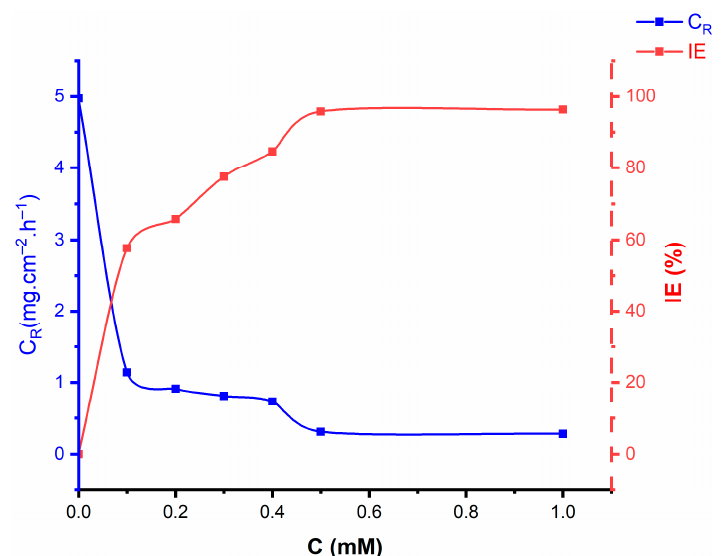
Figure 2. Effect of various concentrations of nicotinehydrazide derivative on the corrosion rate and inhibition efficiency for mild steel immersed in 1 M HCl for 5 h at 303 K.